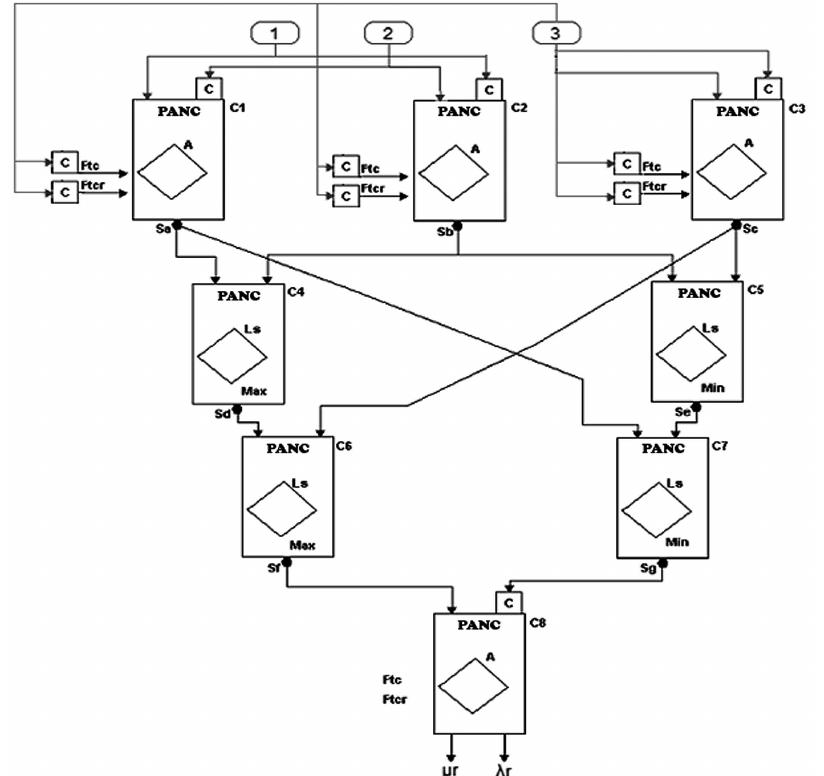
Figure 3 - The architecture for morphological analysis. Three expert systems operate: PA, for check the number of wave peaks; PB, for checking similar points, and PC, for checking different points: The 1st layer of the architecture: C1-PANC which processes input data of PA and PB; C2-PANC which processes input data of PB and PC; C3-PANC which processes input data of PC and PA. The 3rd layer of the architecture: C4-PANC which calculates the maximum evidence value between cells C1 and C2; C5-PANC which calculates the minimum evidence value between cells C2 and C3; C4 and C5 constitute the 2nd layer of the architecture; C6-PANC which calculates the maximum evidence value between cells C4 and C3; C7-PANC which calculates the minimum evidence value between cells C1 and C5. The 4th layer of the architecture: C8 analyzes the experts PA, PB, and PC and gives the resulting decision value. PANC A = Paraconsistent arti fi cial neural cell of analytic connection. PANCLs = Paraconsistent arti fi cial neural cell of simple logic connection of Max maximization. PANCLs = Paraconsistent arti fi cial neural cell of simple logic connection Min of minimization. Ft = Certainty tolerance factor; Ft = Contradiction tolerance factor. S ce ct a = Output of C1 cell; S = Output of C2 cell; S = Output of C3 cell; S = Output of C4 cell; b c d Se = Output of C5 cell; Sf = Output of C6 cell; Sg = Output of C7 cell. C = Complemented value of input; μ = Value of output of PANN; λ = Value of output of r r